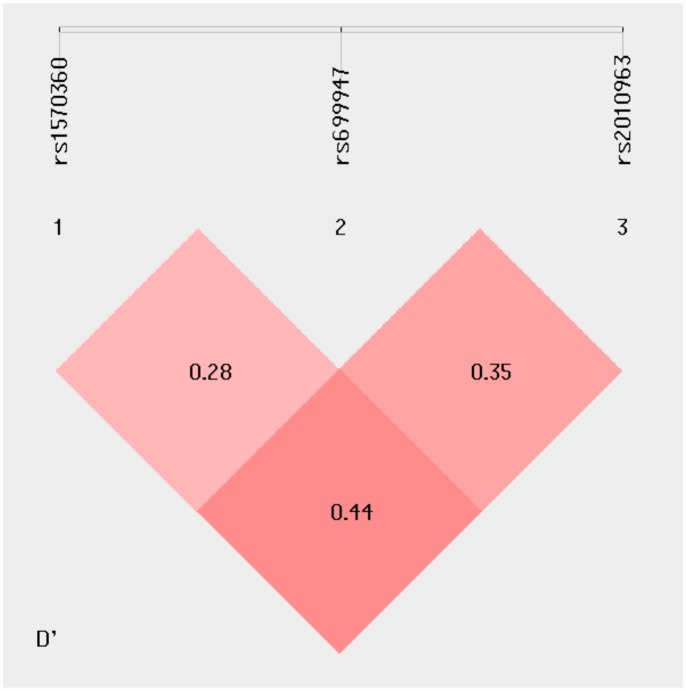
Linkage disequilibrium (LD) plots of three SNPs in the VEGF gene.